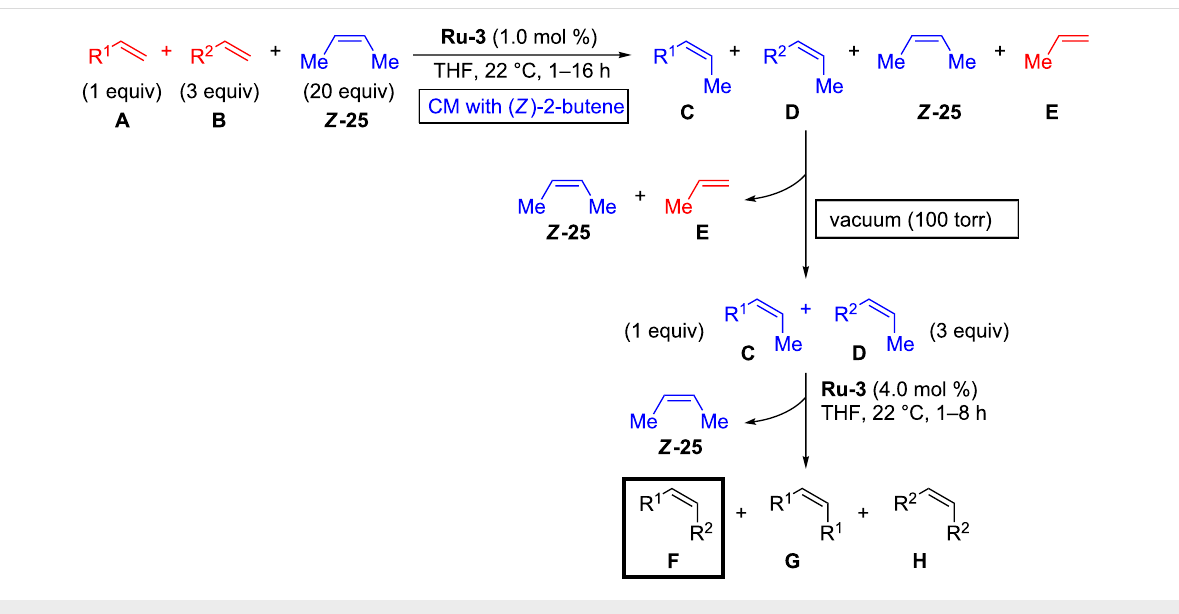
Scheme 5: In situ methylene capping strategy for stereoretentive